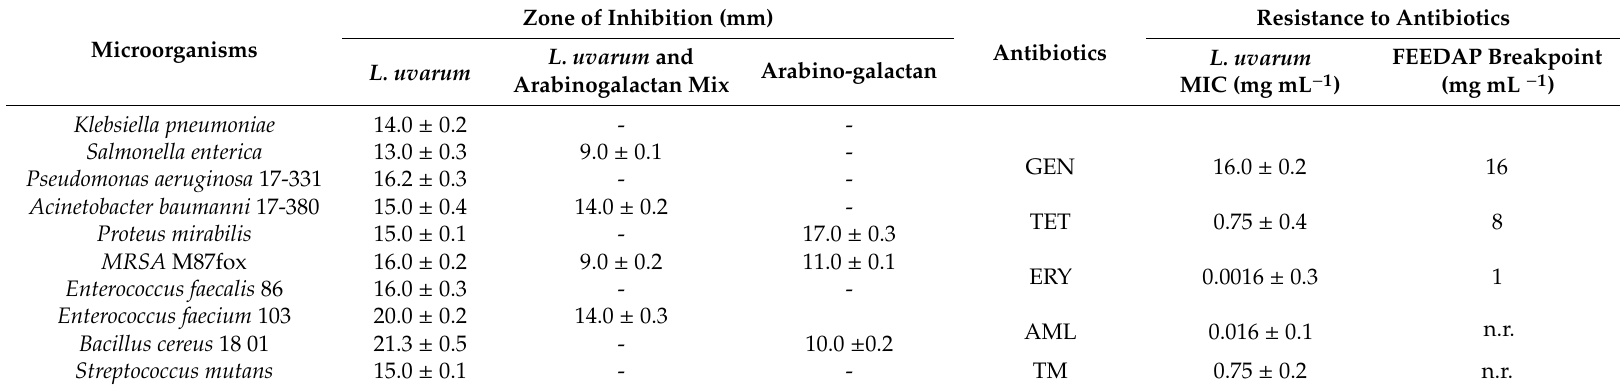
Table 2. Inhibition of the growth of pathogenic bacteria by Lactobacillus uvarum, L. uvarum –arabinogalactan mix, and arabinogalactan powder and their resistance to